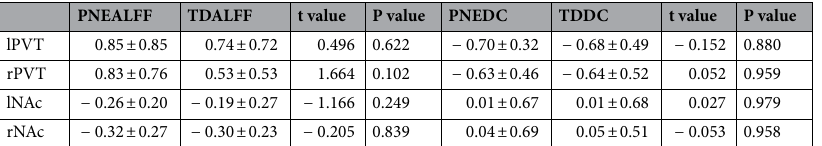
Table 2. The comparison of ALFF and DC value of bilateral PVT and NAc.